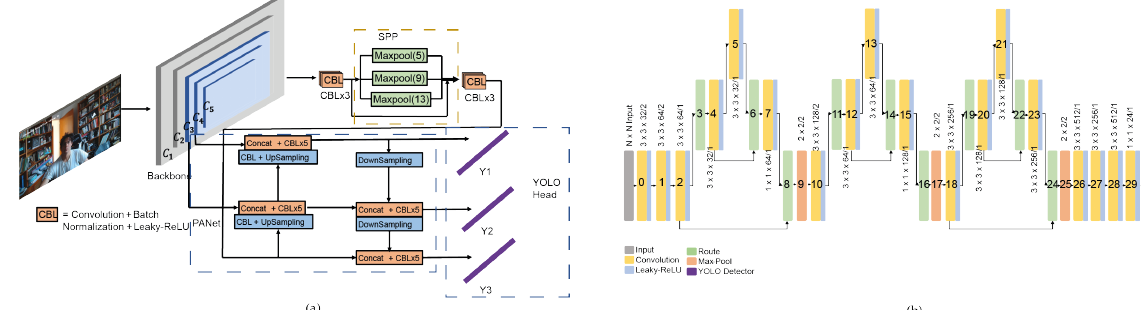
Figure 3. Architectures: ( a ) YOLOv4; and ( b ) Tiny